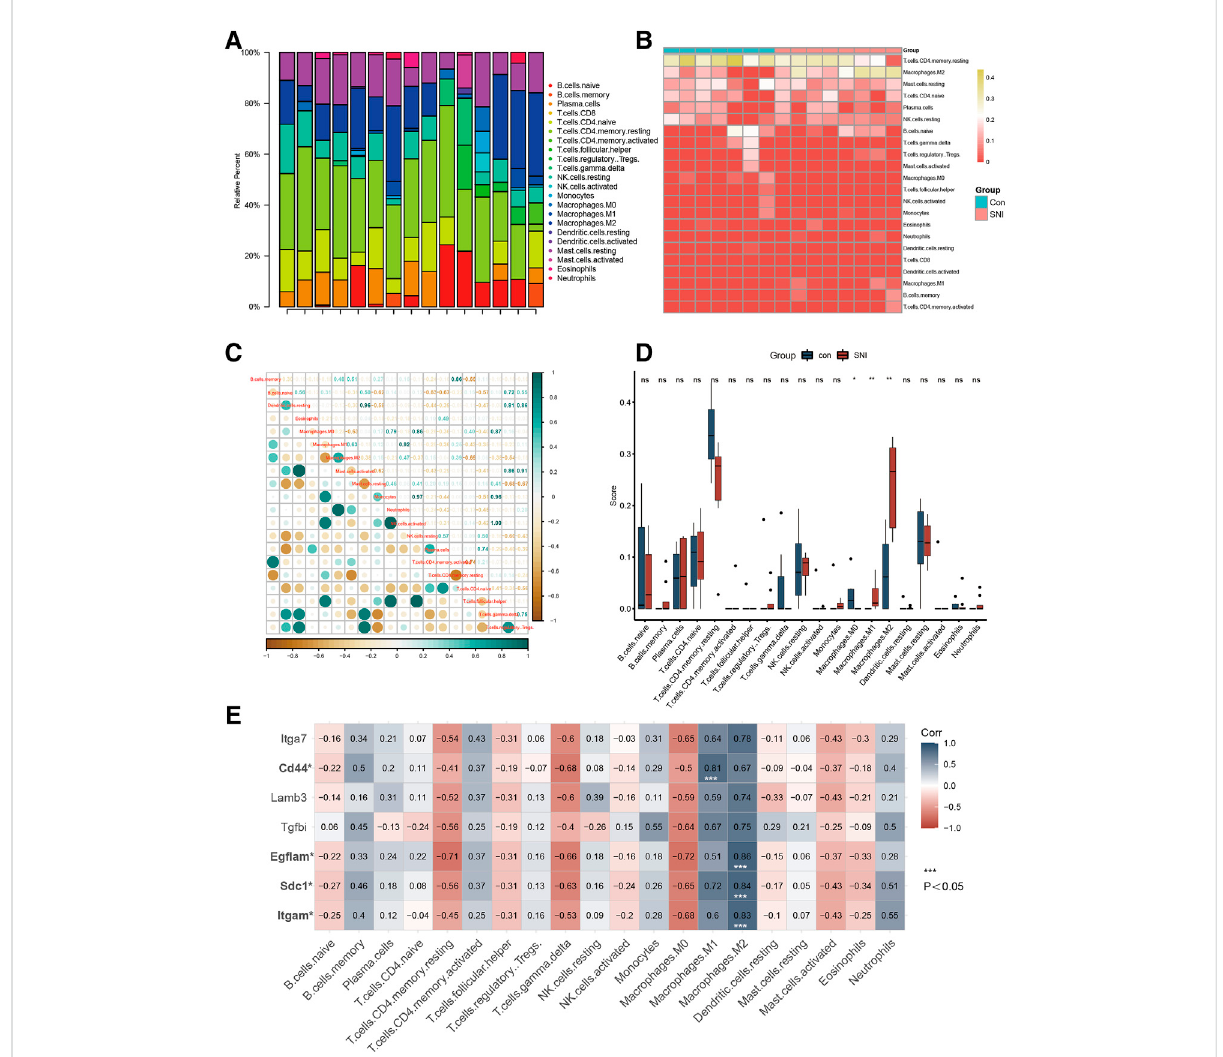
FIGURE 3 Immune in fi ltration analysis and immune-related CG Identi fi cation. (A) Heatmap of 28 immune genes in normal and SNI tissues, according to the CIBERSORT algorithm. (B) Heatmap of the 22 immune cell expressions in normal and SNI tissues. (C) Correlation heatmap of immune cells. (D) The pro fi le difference of 20 immune cells between the SNI and healthy samples. (E) The pro fi le difference of 7 hub genes in 20 immune